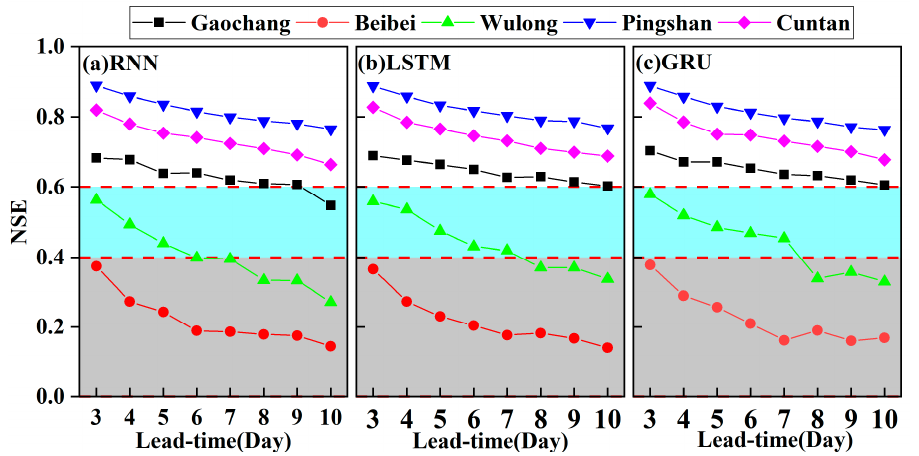
Figure 6. The performance of runoff prediction at the lead times of 3–10 days by ( a ) RNN, ( b ) LSTM, and ( c ) GRU models with optimal time